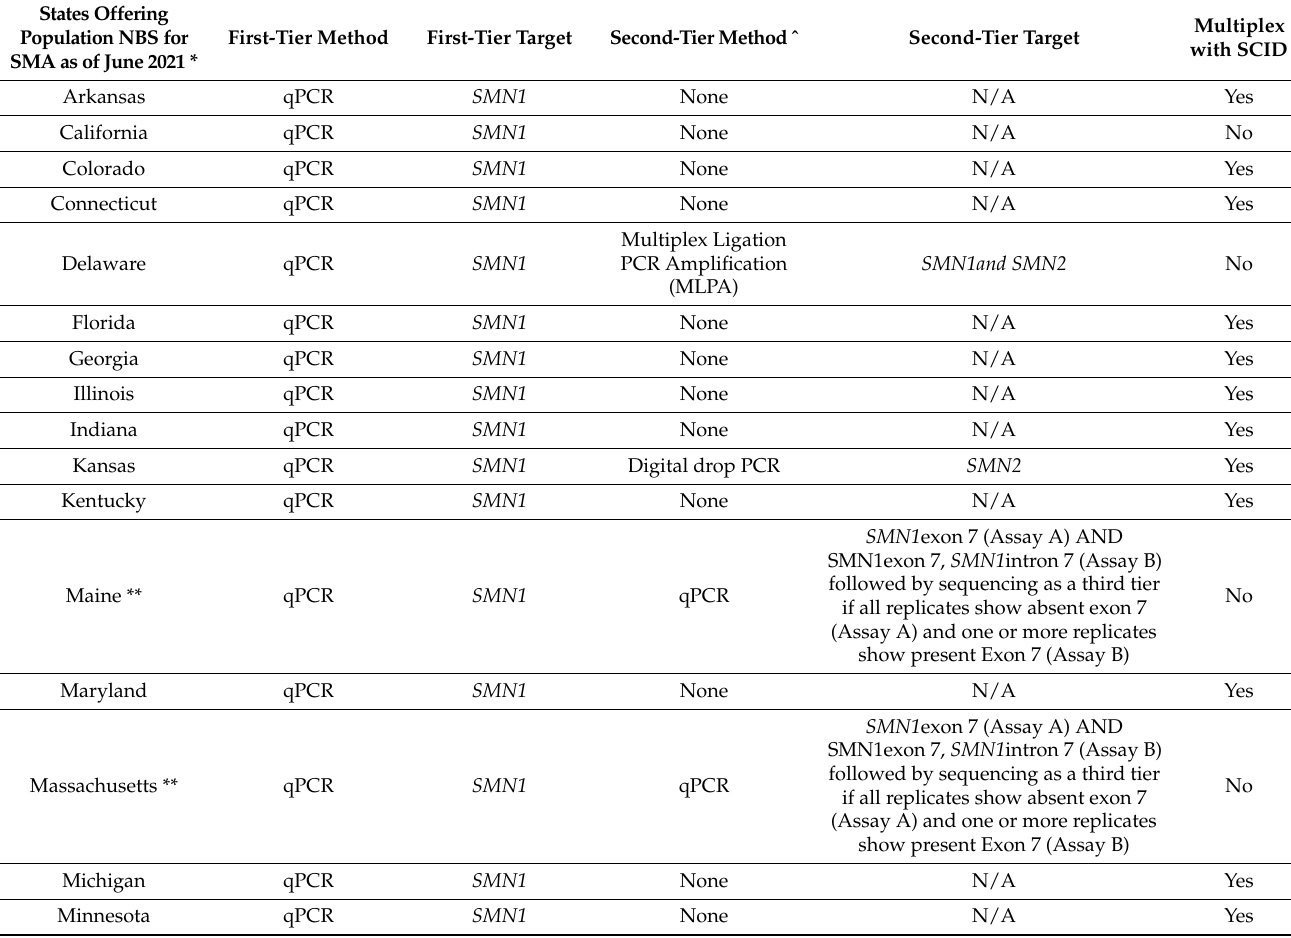
Table A1. State Screening Methods and Targets for SMA Newborn